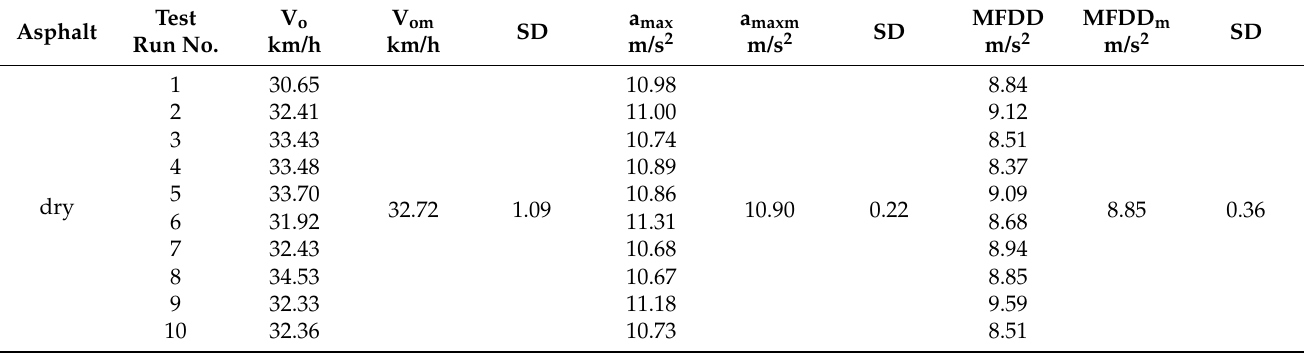
Table 7. The Ford Transit’s deceleration during rapid braking on a dry surface, a wet (after rain) asphalt surface, and a surface covered with a thin ice layer with the initial speed of approximately 30